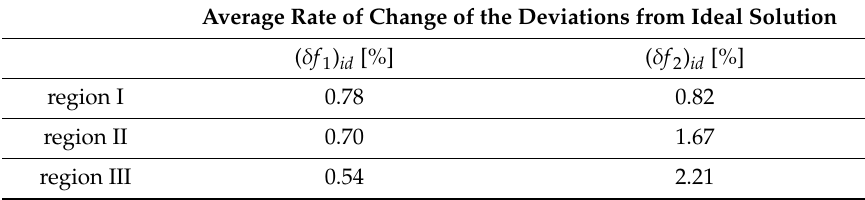
Table 3. Variability of the deviations from ideal solution over considered regions of design